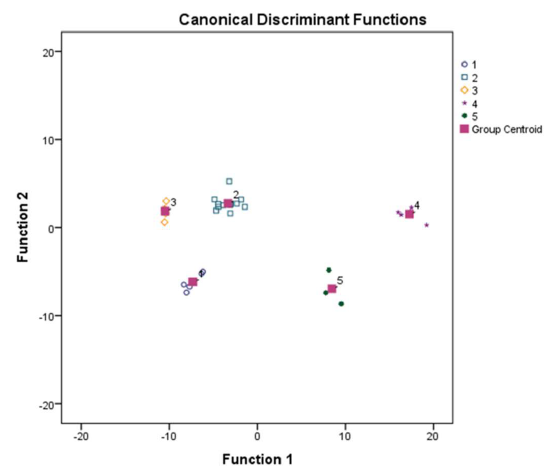
Figure 4. Canonical discriminant function (CDF) illustrates the characteristics of the different clinical subgroups considering regulatory factors / cytokine expression profiles in Plasmodium falciparum- infected patients and healthy control subjects. Function 1 and 2 resulting from CDF, discriminating the EC and NEC from uncomplicated malaria1 (UC1), uncomplicated malaria2 (UC2) and severe malaria (SM) groups according to their relative mRNA expressions (Ct values). Annotation indicates the factors (cytokines and TF’s) that turned out to be relevant for each type of discrimination. CDF discrimination of the clinical subgroups was analyzed using all 39 factors considered for the study. 1 = UC1 (parasitemia < 25,000/μL), 2 = UC2 (parasitemia > 25,000/μL), 3 = SM, 4 = EC and 5 = NEC.